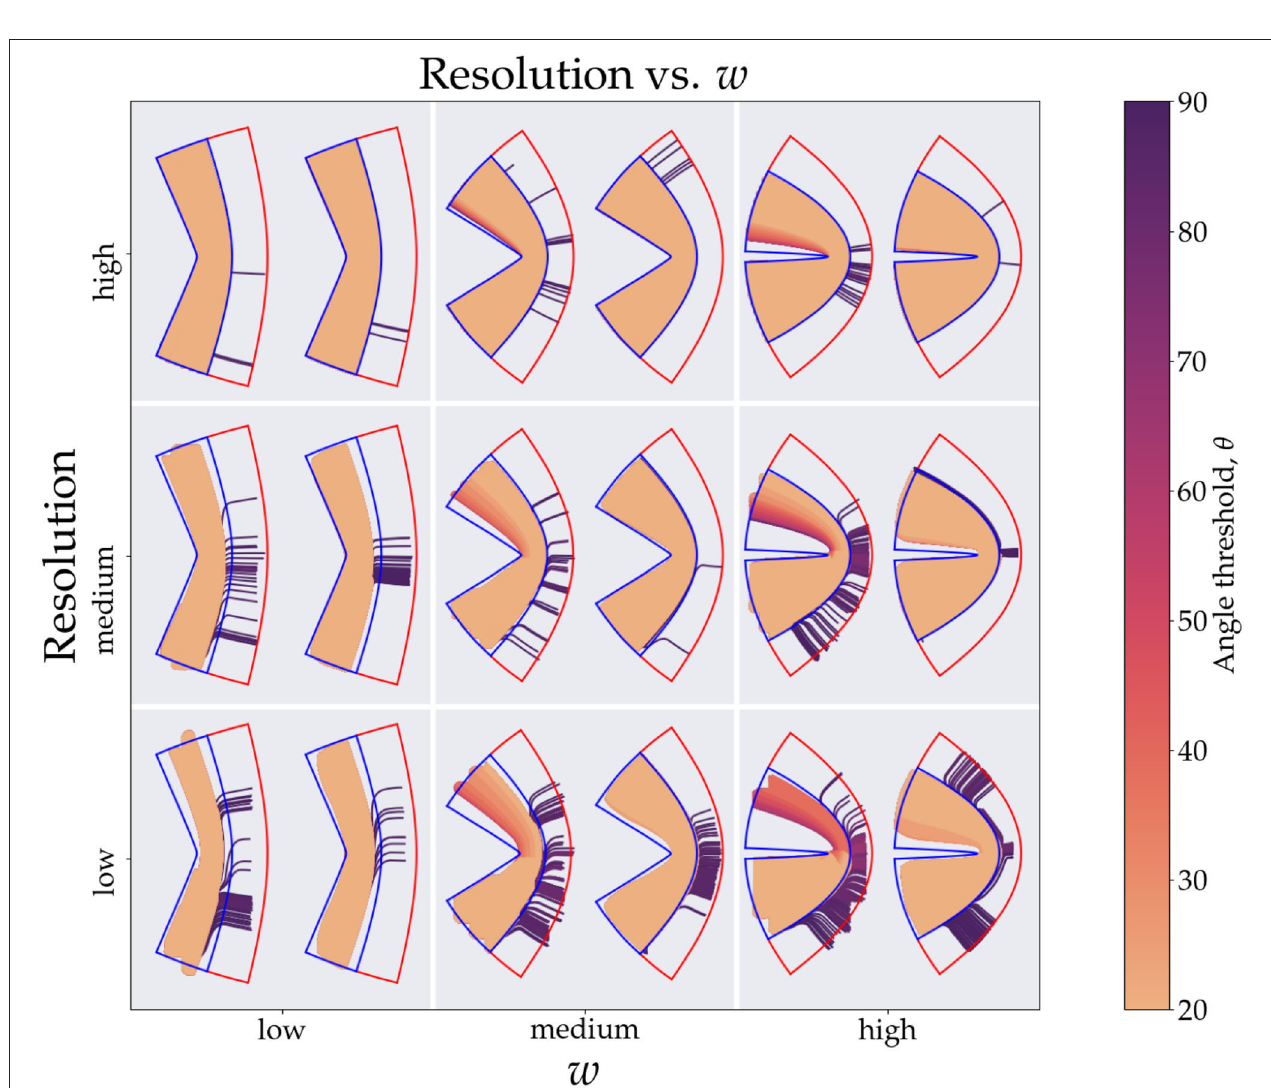
FIGURE 3 | This figure shows the tracts generated from the simulations. For brevity we divide the resolution ( y -axis) and curvature ( x -axis) parameter space into low, medium and high values giving nine tiles. The values for the resolution are 0.2, 0.7, and 1.2 mm, respectively, and the values for the curvature are 1.24, 1.66, and 1.99, respectively. In each tile the left image is generated from using Cartesian coordinates and right one is from using conformal coordinates. The colors of the tracts represent the angle threshold used. The blue outline shows the tangential region and the red shows the radial region. Since the high angle threshold (purple) tracts occupy the most area they are plotted first and the lowest angle threshold tracts (orange) are plotted